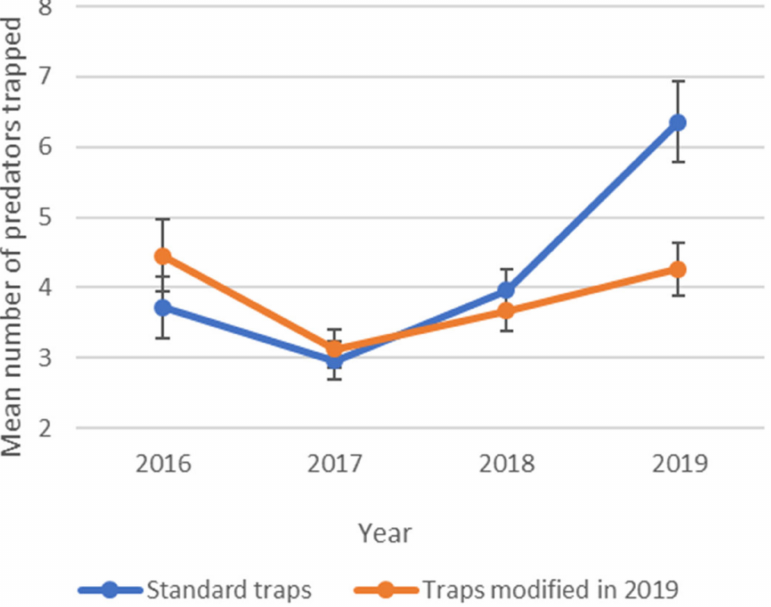
Figure 6. Mean catches per trap per control date of T. caerulea and T. formicarius in standard and modified traps in the study site (Municipality of Grosseto, Tuscany, Italy). Trap modifications were not present until 2019; however, trap position never changed during the four-year study. Bars indicate standard